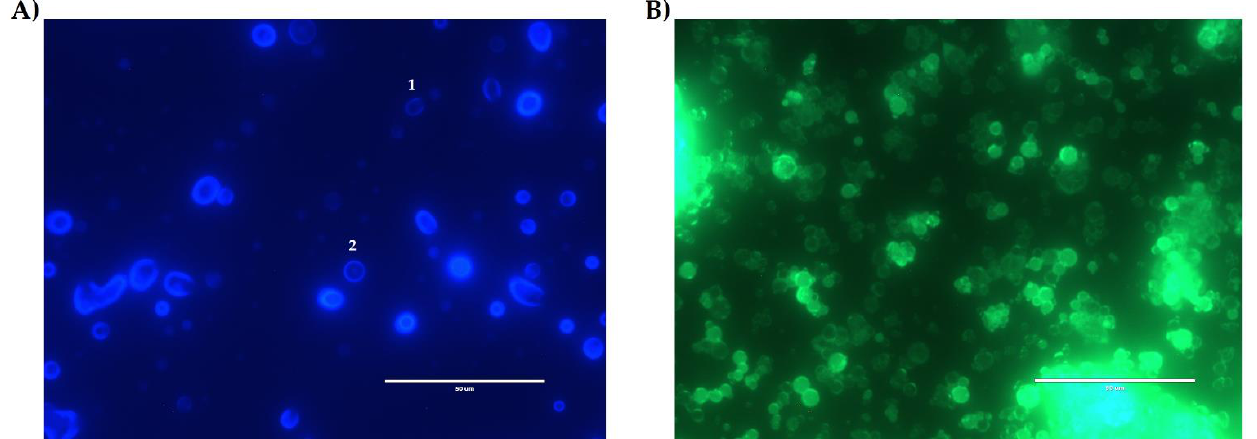
Figure 7. Fluorescence microscopy. ( A ) Inulin nanoparticles loaded with quercetin (NQs) sample with a DAPI filter in organic solution (ethanol). ( B ) NQ sample with GFP filter in organic solution (ethanol). * The numbers in image A indicate: 1. NQs with deficit of loaded quercetin. 2. NQs with quercetin adhered to the surface of the polymeric matrix. White bar represents scale at 50 μm (60 × magnification).